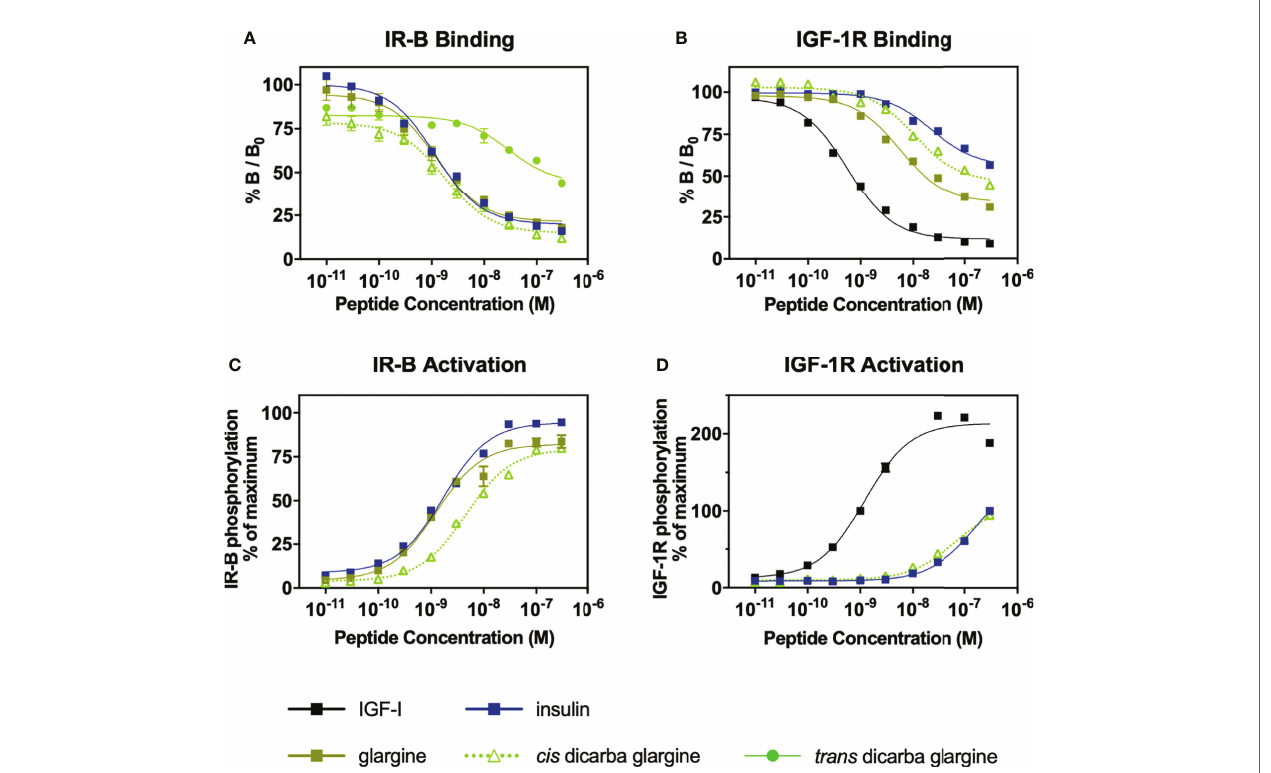
FIGURE 2 | Receptor binding and activation of insulin, glargine and dicarba glargine analogues. (A) Competition binding of insulin, glargine and dicarba glargine analogues with europium-labelled insulin for the IR-B and (B) with europium-labelled IGF-I for the IGF-1R. Results are expressed as a percentage of binding in the absence of competing ligand (%B/B 0 ). (C) Activation of IR-B and (D) IGF-1R by increasing concentrations of each insulin analogue (10 min stimulation) is expressed as a percentage of the maximal receptor phosphorylation induced by insulin. All data are the mean ± S.E.M. n = at least 3 independent experiments. Error bars are shown when greater than the size of the symbols. Competition binding of insulin, glargine and dicarba glargine analogues with europium-labelled insulin for the IR-A were also performed (see Figure S2